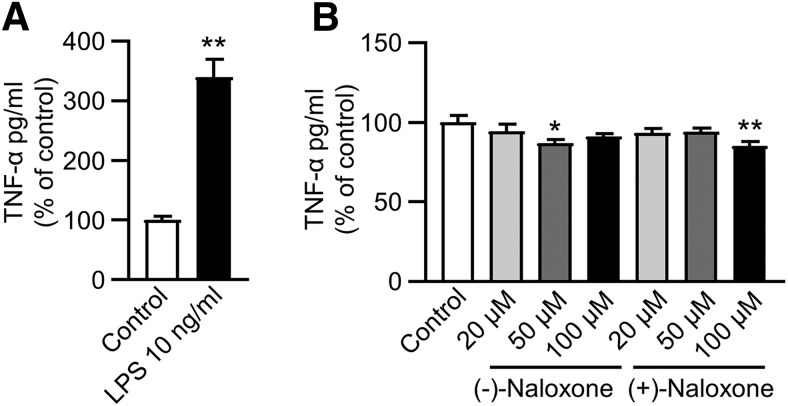
Naloxone reduced TNF-α secretion from CD11b+ cells. A, LPS induced TNF-α secretion from CD11b-expressing cells isolated from the infarct area of rat brain 7 d after dMCAo. **, p < 0.01, Mann–Whitney U test; control n = 6, LPS n = 5 in 2 independent experiments. B, CD11b+ cells were isolated from the infarct area and treated with different concentrations of naloxone as indicated for 20 h. *, p < 0.05 and **, p < 0.01 indicate pairwise comparison with the control group by Dunnett’s post hoc test following one-way ANOVA; control n = 9, naloxone n = 8–9 in 3 independent experiments. The culture medium was analyzed using TNF-α ELISA. The data represent mean ± SEM.